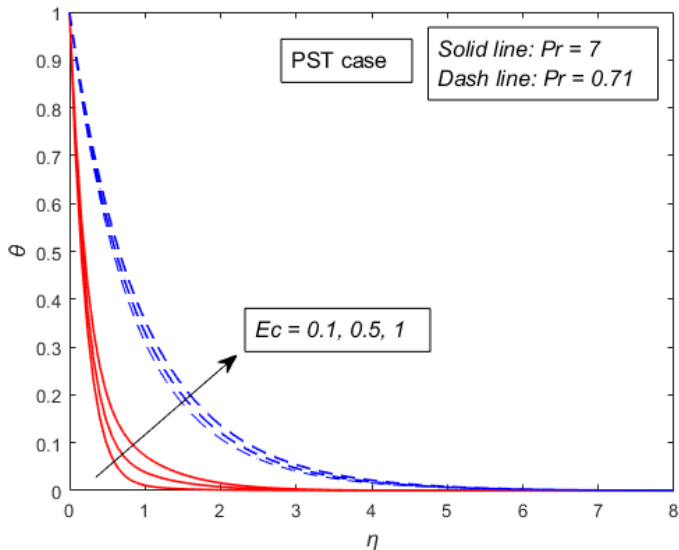
Figure 10. Variation of the temperature profile for different values of Eckert number Ec and Prandtl number Pr for the PST case when n = 3, K = 1, and M =